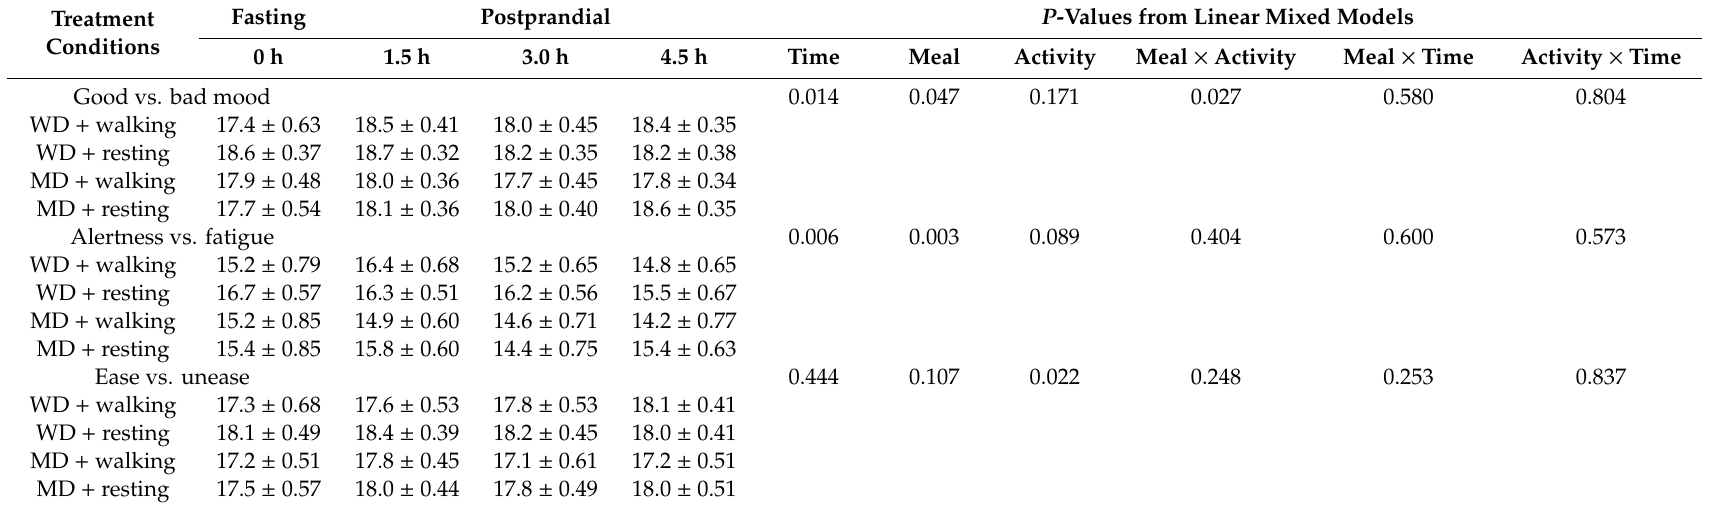
Table 4. Fasting and postprandial parameters of MDMQ